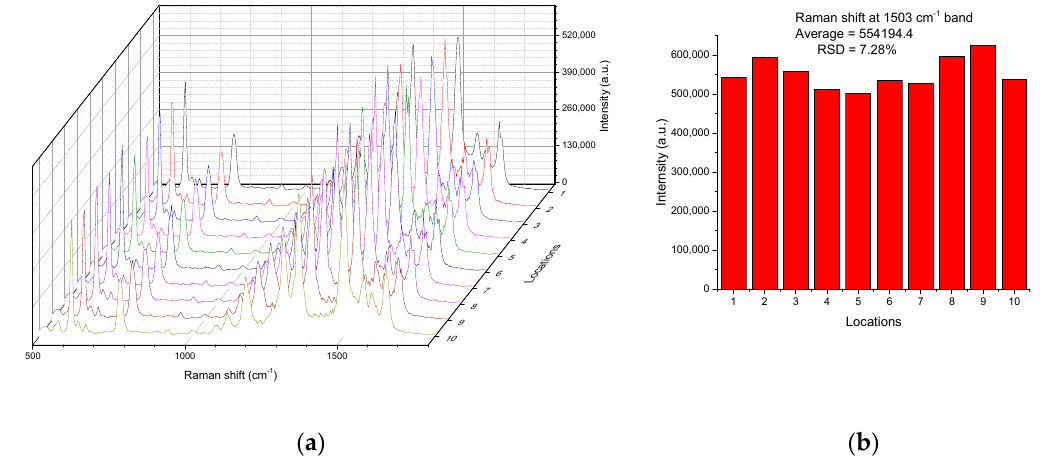
Figure 10 . ( a ) The SERS spectra of R6G measured from 10 random positions of the SERS substrate. ( b ) The SERS intensities of the Raman characteristic peak of the 1503 cm − 1 band from these locations. The developed SERS substrates were also tested with low concentration DEHP solution. Figure 11 shows measured SERS spectra for DEHP concentrations ranging from 1000 ppm to 2 ppm on SERS substrates. The Raman band assignment of the main peaks for DEHP are given in Figure 11. Raman peaks of DEHP at 1055 and 1433 cm − 1 are aromatic ring breathing and C=C stretch, respectively. The characteristic peaks of DEHP at 1055, 1433 cm − 1 are clearly observed from the spectrum. The SERS substrates were found to be able to detect a low concentration (2 ppm) DEHP methanol solution.